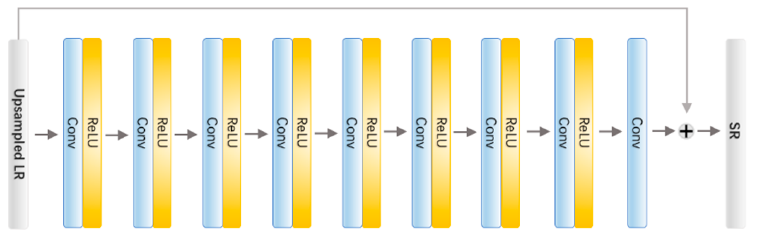
Figure 2. The architecture of the foundation network. The network takes upsampled LR image as input tensor with shape 𝐻 × 𝑊 × 𝐶 × 𝐹 , where H, W, C and F denote height, width, channels (3 as default) and the number of filters (64 in our setting), respectively.